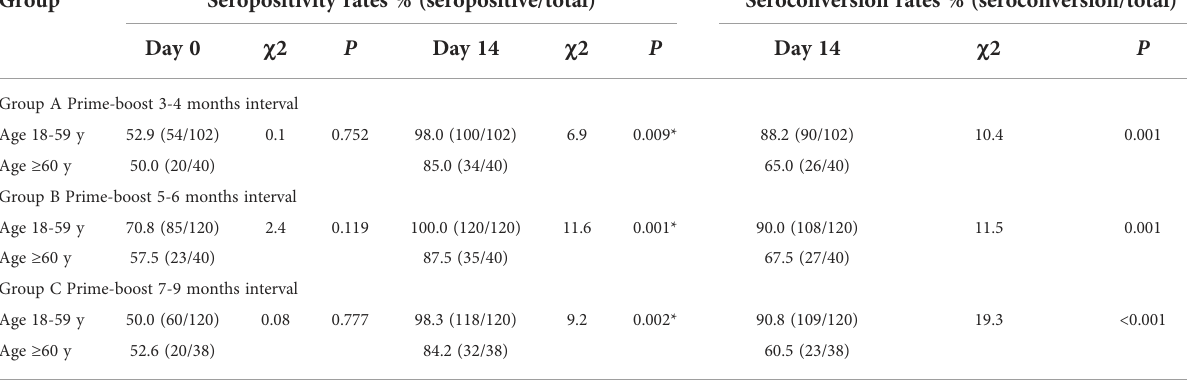
TABLE 2 Different groups with seropositivity rates and seroconversion rates at each timepoint. Group